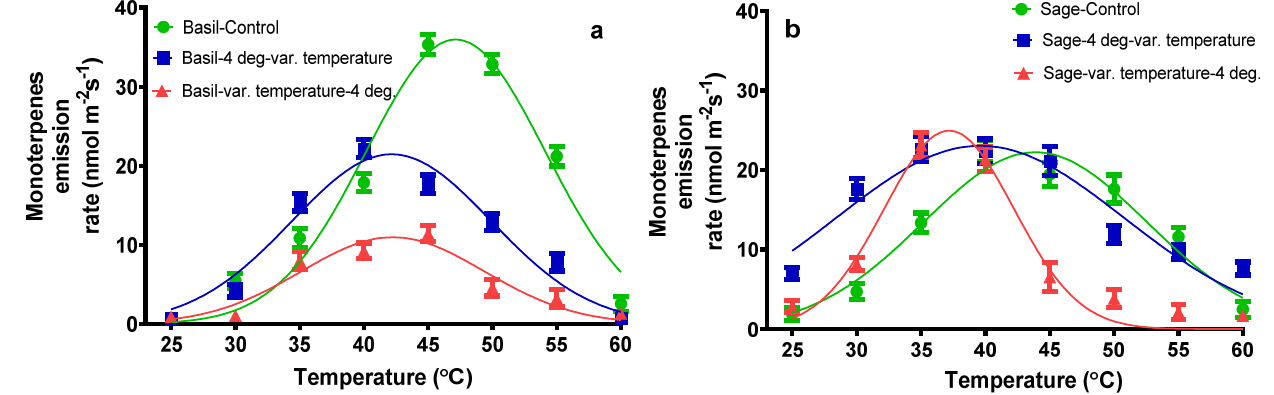
Figure 4. The monoterpenes’ emission rate from basil plants ( a ) and sage plants ( b ); plants were subjected to different temperatures.